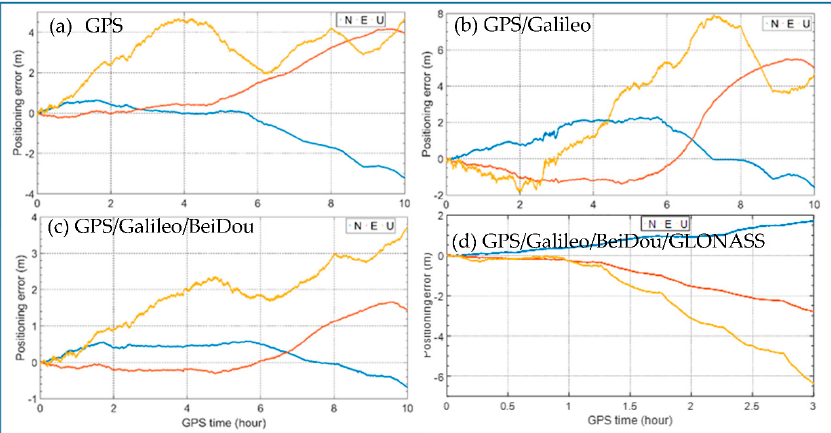
Figure 8. The 10-h time-relative positioning errors with the starting hour 00:00 ( a : GPS, b : GPS/Galileo, c : GPS/Gali- leo/GLONASS, d : GPS/Galileo/BeiDou/GLONASS).